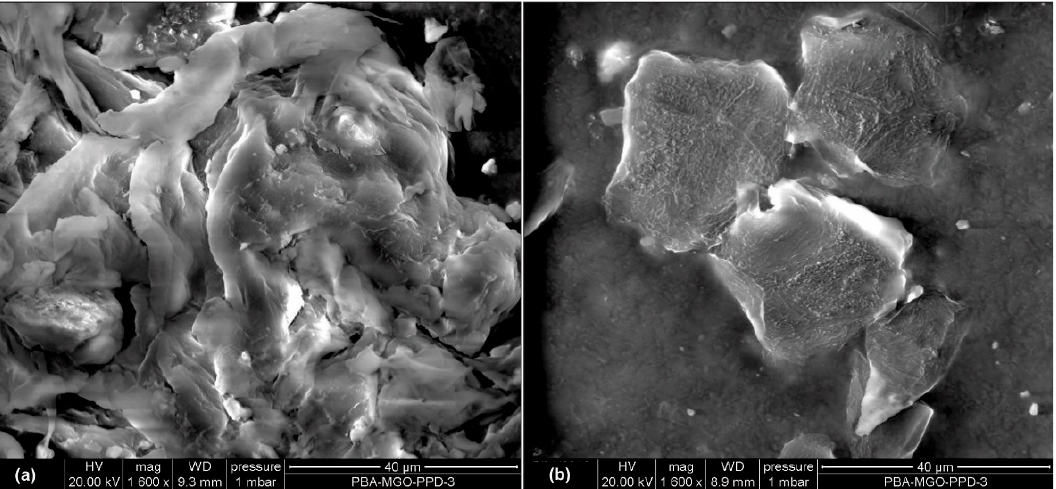
Figure 13. Scanning electron microscopy (SEM) of ( a ) 3% MPGE with a crosslinking agent and ( b ) 3% MPGE.